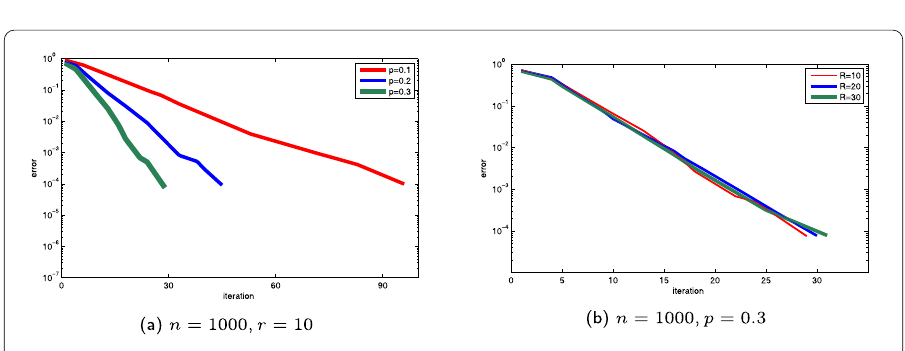
Figure 2 Convergence behavior of the relative error in the MOLRMA algorithm